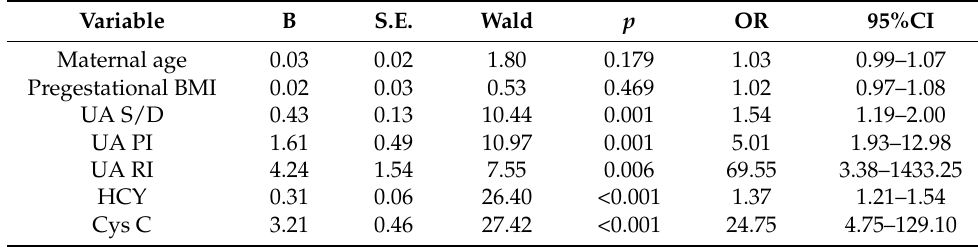
Table 8. Logistic regression